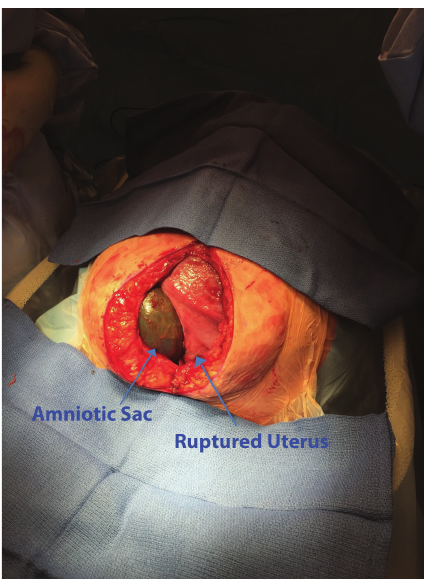
Figure 1: Silent uterine rupture, with extruded amniotic